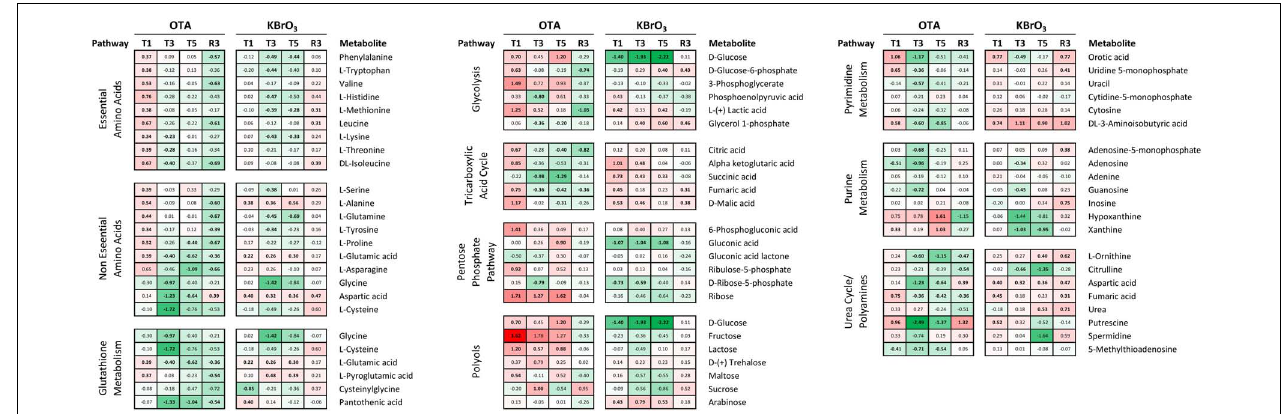
FIGURE 7 | Effects on metabolite levels in RPTEC/TERT1 cell lysates. Intracellular metabolites were measured in methanol lysates by GC-MS at the four indicated time points. Data is shown as log2 fold over time-matched control (LFC). Metabolites are grouped per pathway and appear multiple times if shared between pathways. Heatmap ranges from 3.62 (fructose / OTA T1, red) to –2.22 (glucose / KBrO 3 T5) and is centered to 0 (white). Bold LFCs indicate LFC significantly different from control, as determined by 2-way ANOVA with Sidak posttest ( p ≤